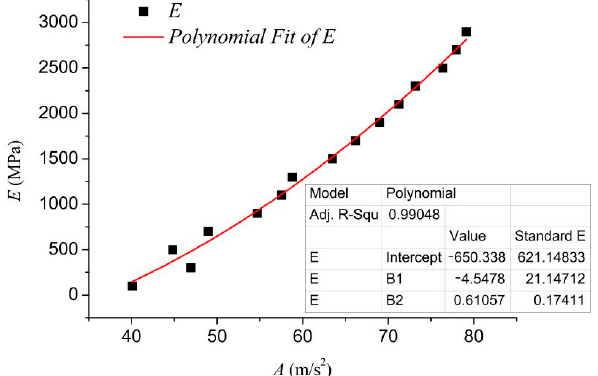
Figure 10. Fitting curve of the relationship between A and composite modulus.